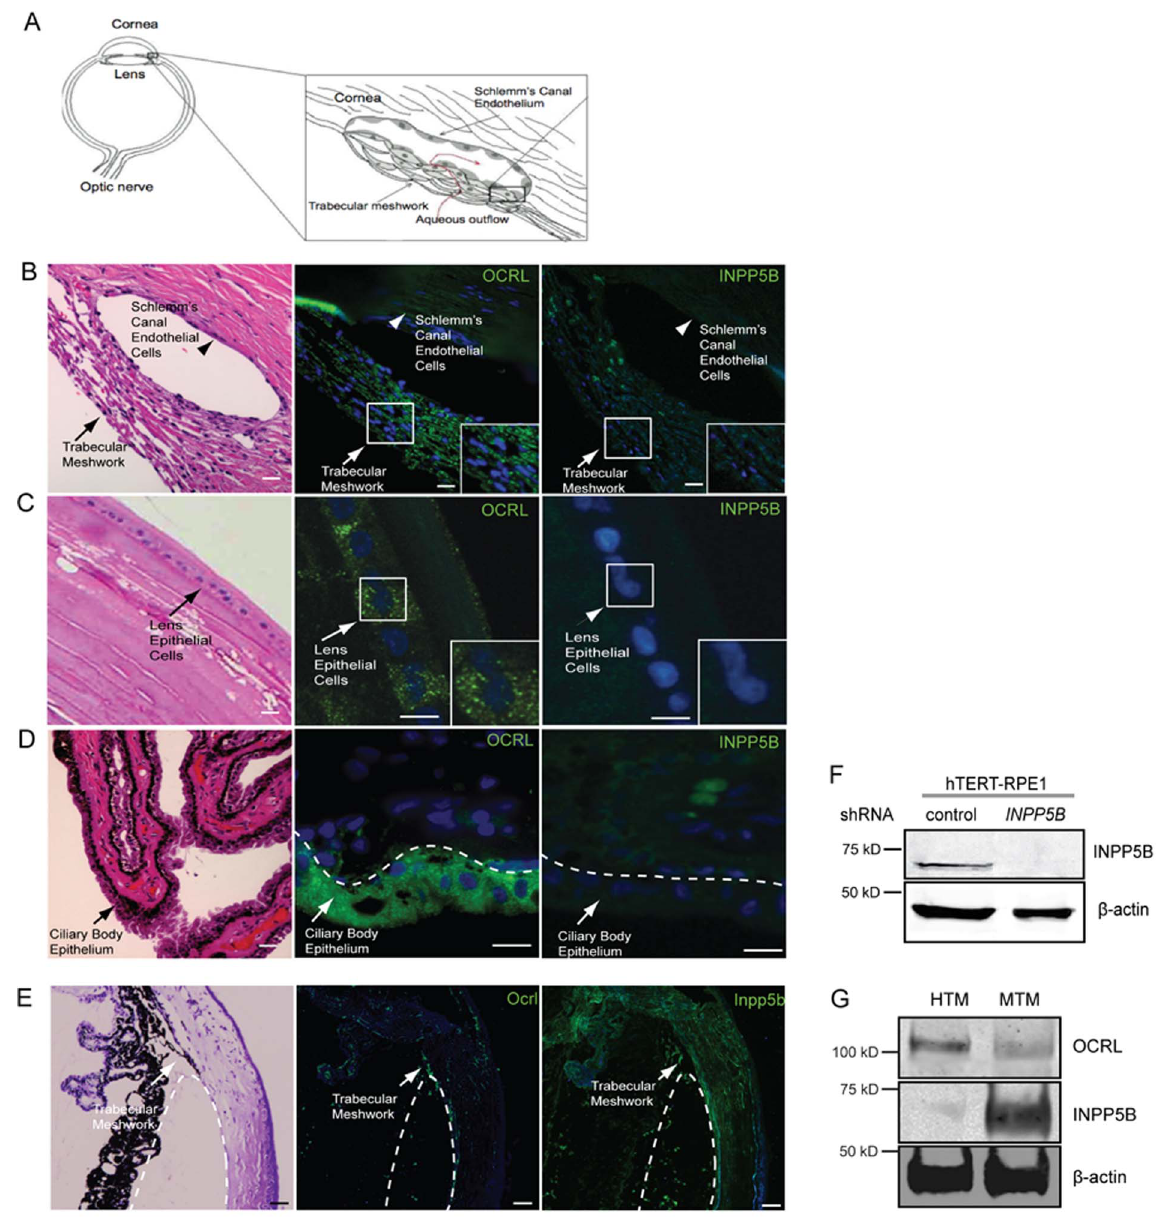
Figure 1. Localization of OCRL and INPP5B in human ocular tissue. (A) Diagram of trabecular meshwork and Schlemm’s canal endothelial cells (aqueous flow, red; trabecular meshwork, arrow; Schlemm’s canal endothelial cells, arrowhead). (B) Human eye sectioned and stained by H&E or immunofluorescence with anti-OCRL (green) or anti-INPP5B antibody (green), and DAPI (blue). Staining of trabecular meshwork cells in vesicular pattern (insert, arrow) and Schlemm’s canal (arrowhead). Scale bar 10 micron. (C) Lens epithelial cells (arrow) stained with H&E, anti-OCRL antibody (green) or anti-INPP5B antibody (green), and DAPI (blue). Scale bar 10 micron. (D) Ciliary body epithelial (arrowhead) cells stained with H&E, anti-OCRL antibody (green) or anti-INPP5B antibody (green), and DAPI (blue). Scale bar 10 micron. (E) Mouse eye sectioned and stained with H&E, anti-OCRL antibody (green) or anti-INPP5B antibody (green), and DAPI (blue). Staining of trabecular meshwork cells in vesicular pattern (dash line indicates border of trabecular meshwork). Scale bar 10 micron. (F) Immunoblot of INPP5B expression in 30 microgram lysates of hTERT-RPE1 shRNA knockdown cells compared to beta-actin. (G) Immunoblot analysis of 40 microgram lysates of human and mouse trabecular meshwork with anti-OCRL, anti- INPP5B and anti-beta-actin antibodies.